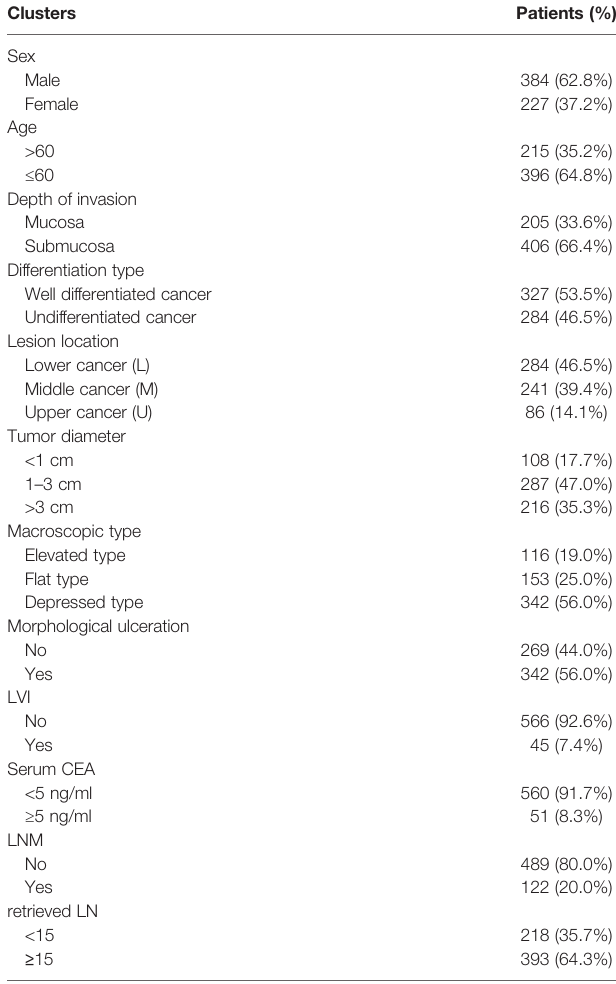
TABLE 1 | Demographics of 611 patients with early gastric cancer. Clusters Patients